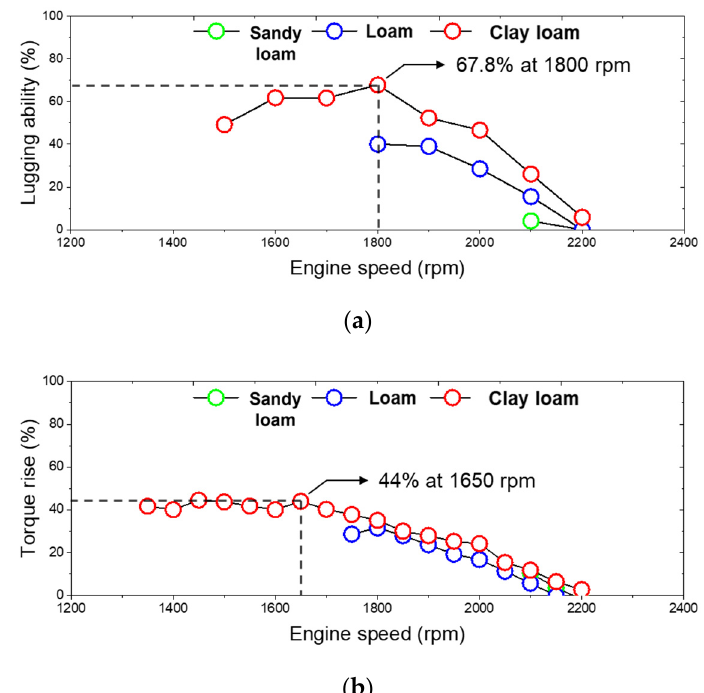
Figure 12. ( a ) Lugging ability; ( b ) torque rise ranges.